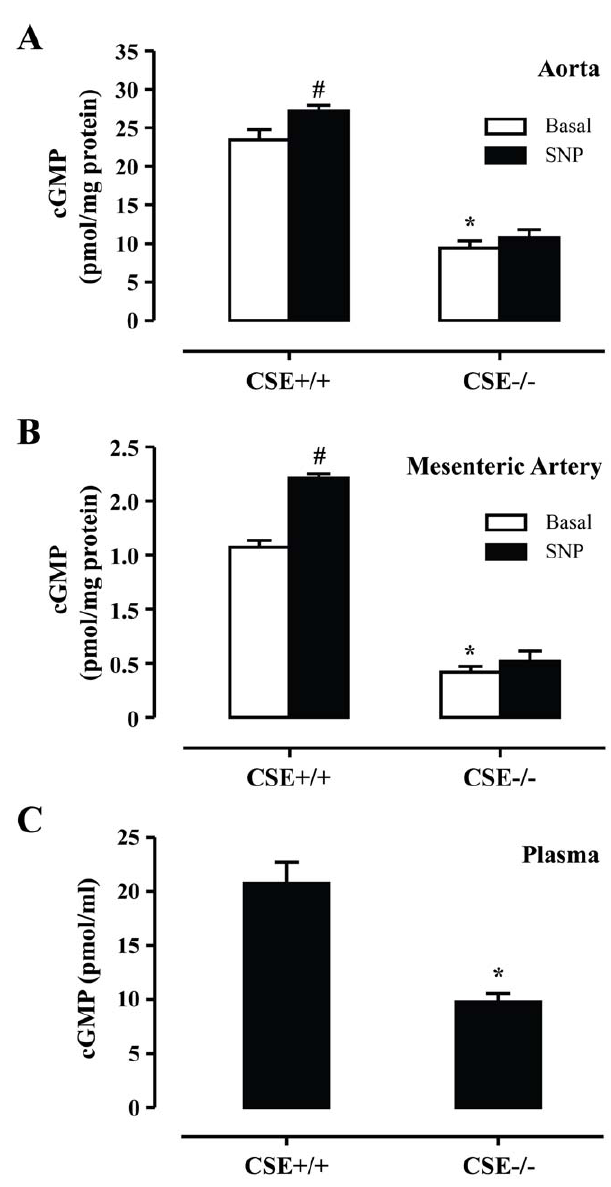
Figure 2. CSE deficiency reduces cGMP levels. cGMP levels in the aorta (A), mesenteric artery (B) and plasma (C) of CSE 2 / 2 mice were significantly lower than those from CSE + / + mice. Sodium nitroprusside (SNP, 10 m M) significantly increased cGMP levels in aorta (B) and mesenteric artery (C) from CSE + / + mice but not CSE 2 / 2 mice; * p , 0.05 vs CSE + / + mice, # p , 0.05 basal, n=5 for each